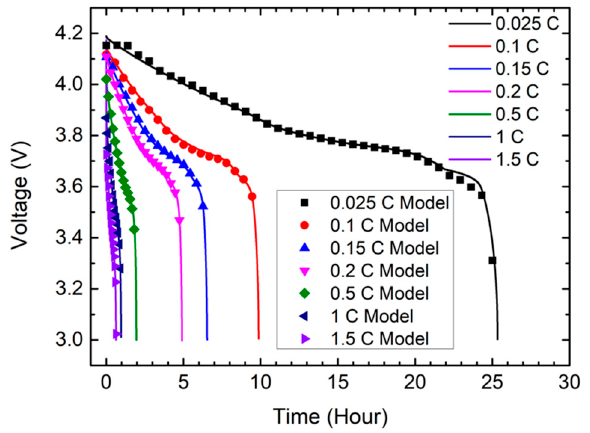
Figure 15. Curve of P brand 18650, Epoch = 100, look_back = 10.